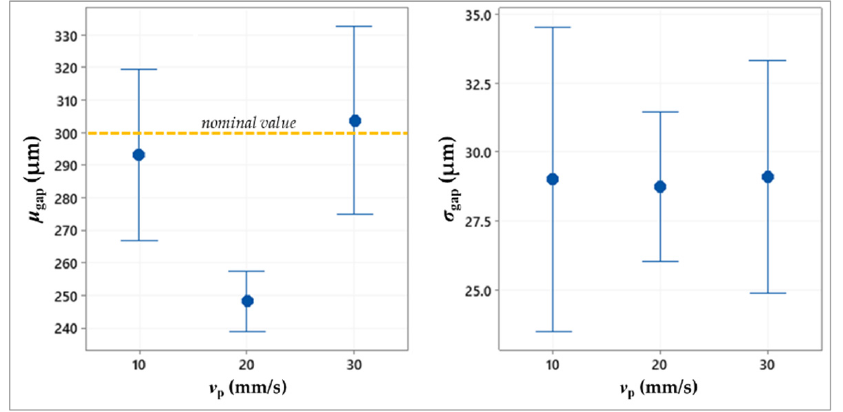
Figure 7. Interval plot of the mean value and standard deviation of the gap against the printing speed.